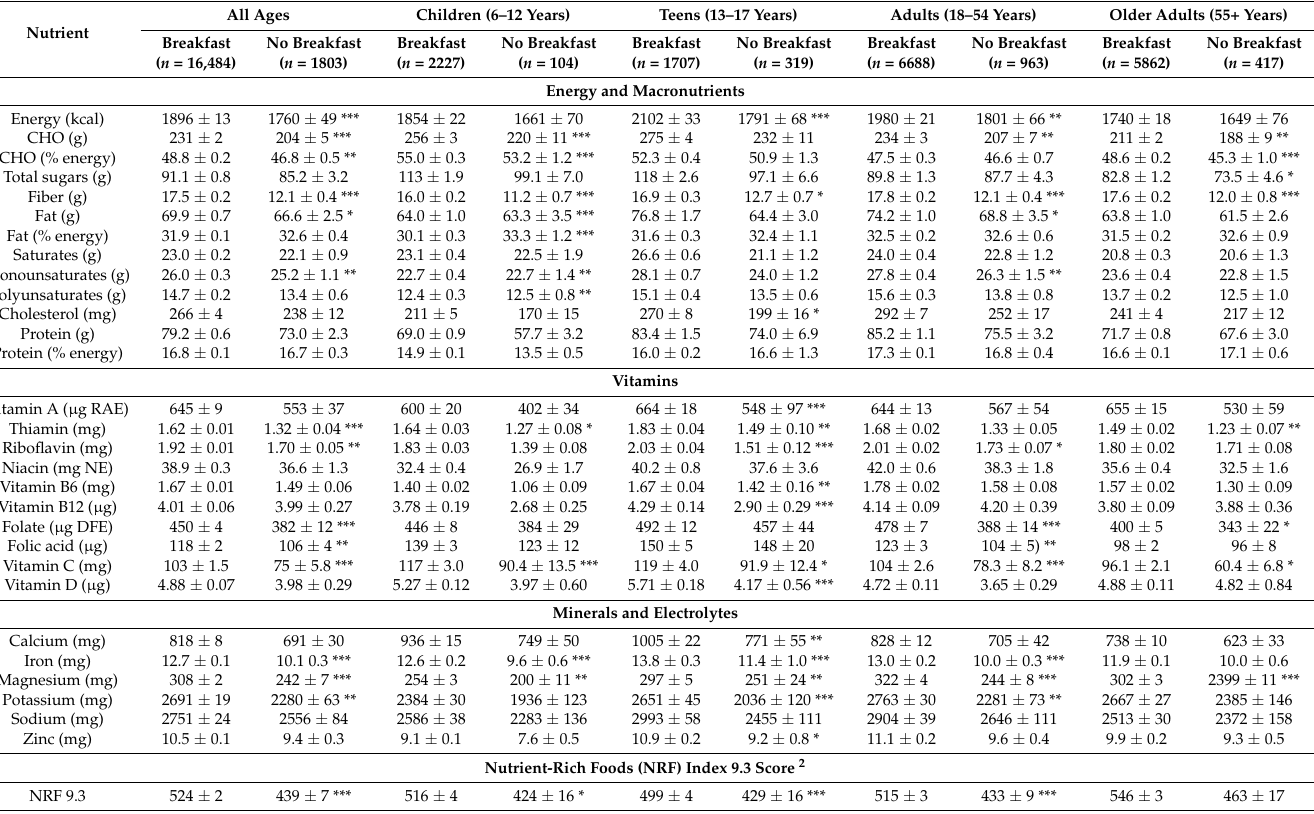
Table 2. Daily energy and nutrient intakes of Canadian breakfast consumers and non-consumers 1